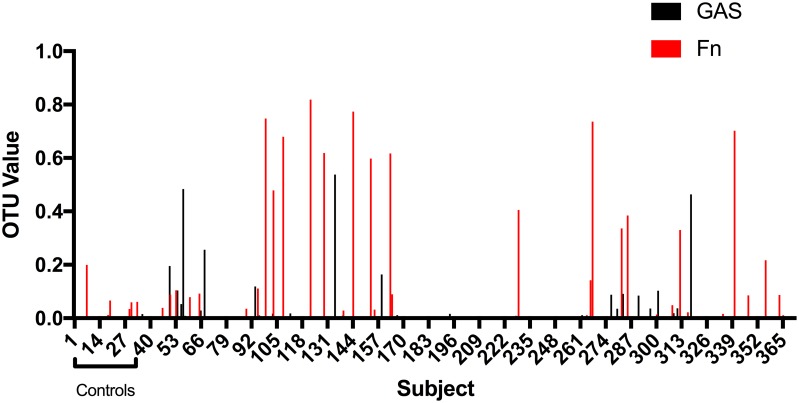
Microbiome analysis of throat swabs from 367 subjects (30 controls and 337 sore throat patients).Shown are the relative proportions of OTUs with higher values represented by Fusobacterium necrophorum and Streptococcus pyogenes. Many positive samples (OTU values less than 0.01) cannot be seen on this scale.